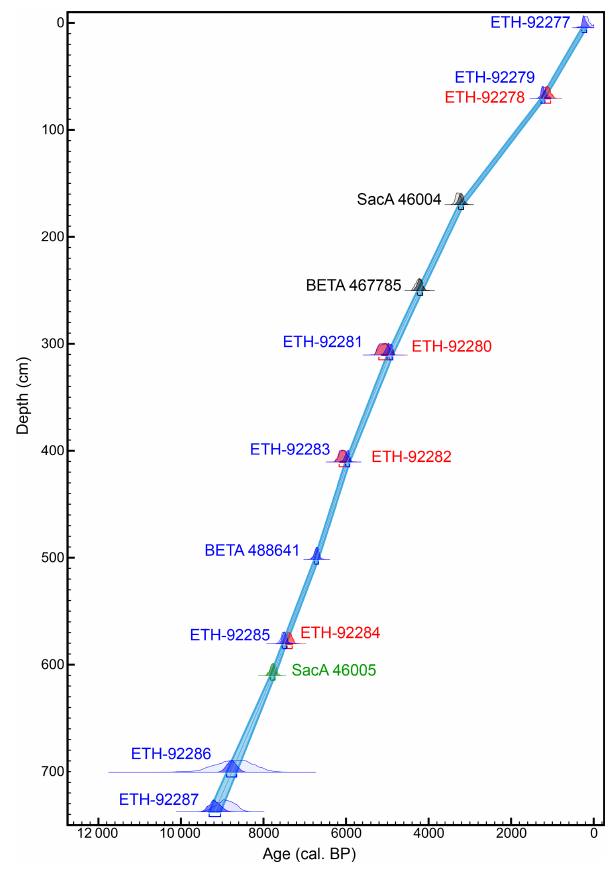
Figure 3. Age model for core AMD14-204C based on 11 radiocar- bon dates (the green, black, and blue dates). The light-blue envelope represents the modelled 1 σ range, and the blue line marks the mod- elled median age. The light shaded areas for each radiocarbon date indicate the probability distribution prior to age modelling, whereas the darker areas indicate the posterior probability distribution. Blue: mixed benthic foraminifera; red: mixed planktonic foraminifera; grey: mixed planktonic and benthic foraminifera; green: mixed os- tracods and planktonic and benthic